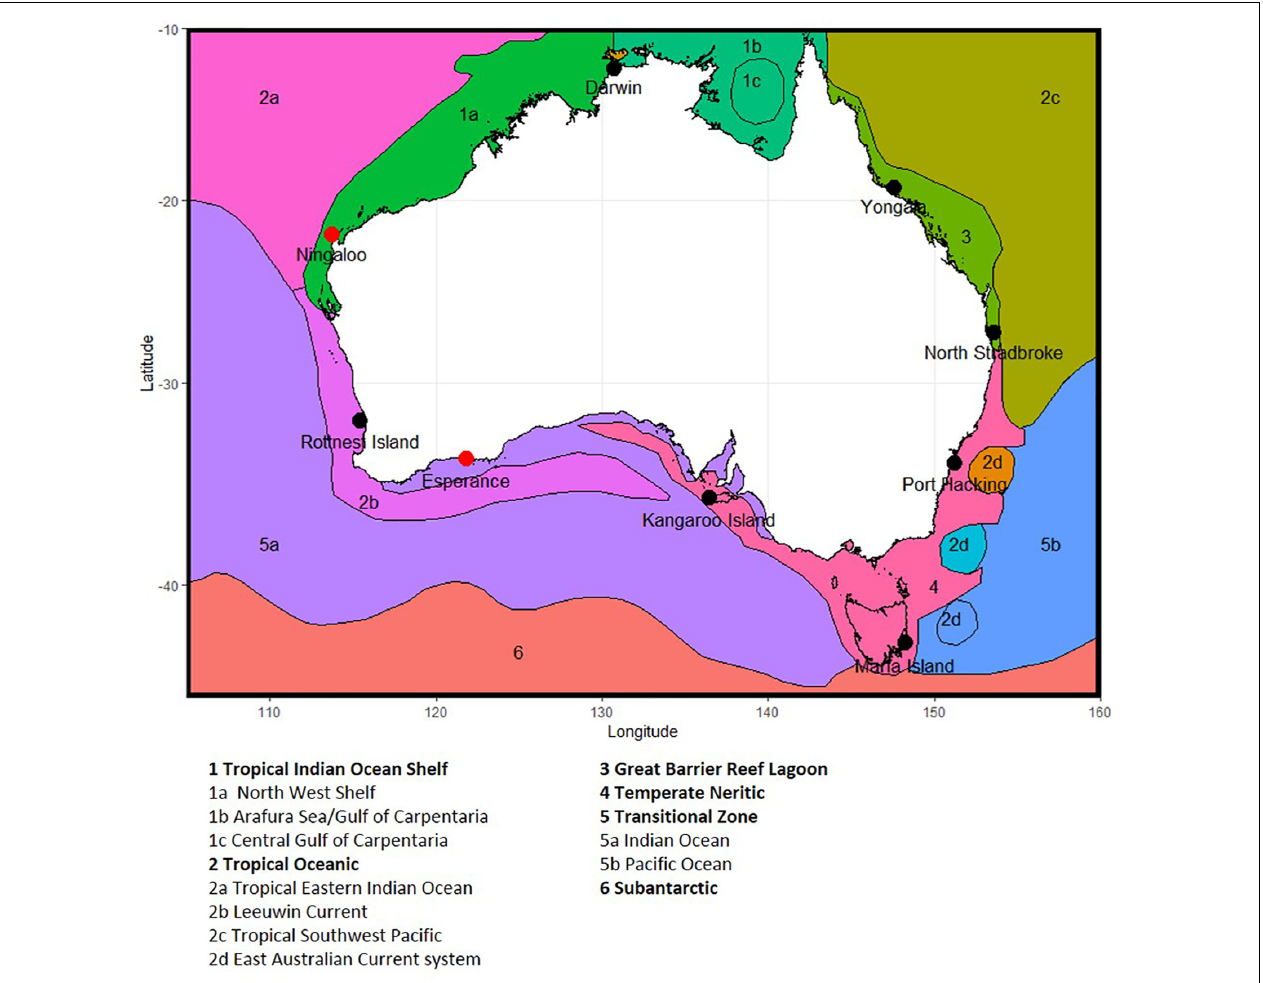
FIGURE 1 | Location of National Reference Station sites around Australia, showing phytoplankton provinces, based on Hallegraeff et al. (2017) and Hayes et al. (2005). Note Ningaloo and Esperance (shown as red dots) are no longer sampled due to resource constraints, and Darwin and Kangaroos Island have seasonal sampling (see section